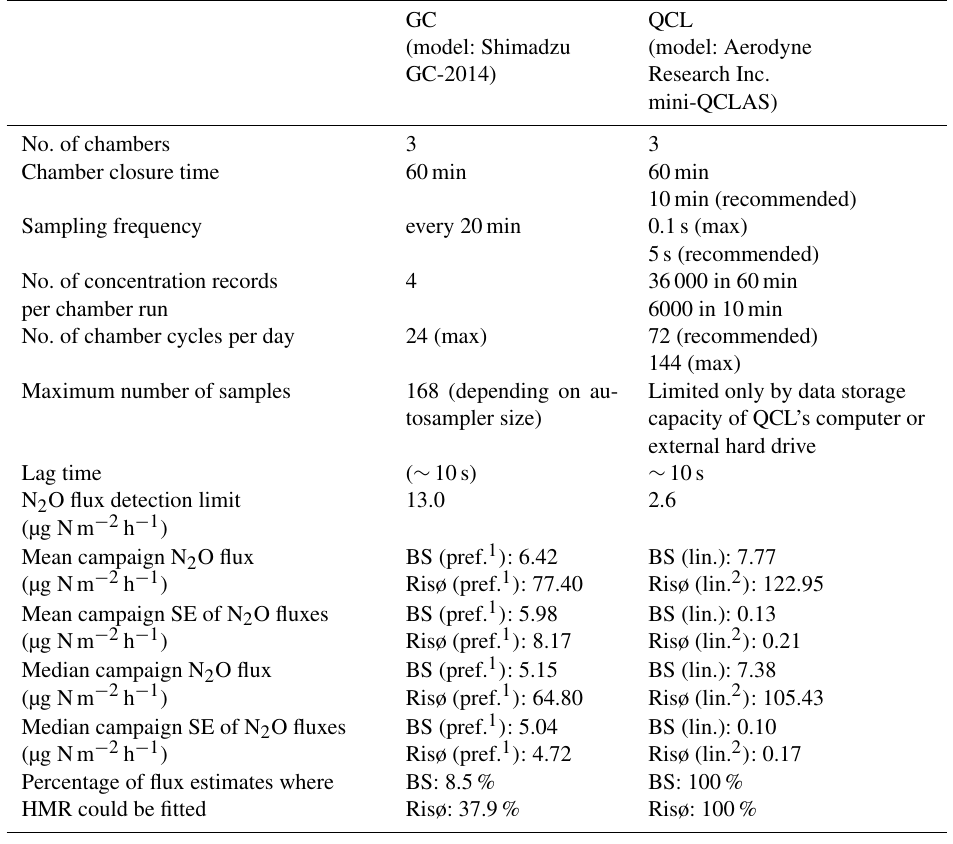
Table 2. Features of the chamber-analyzer system used in this